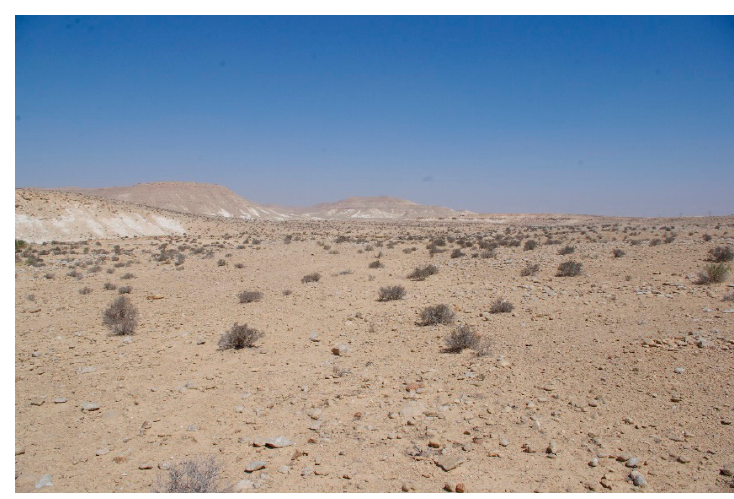
Figure 4. ‘Natural’ land; downslope view. Photo taken by I. Stavi, on summer 2017.